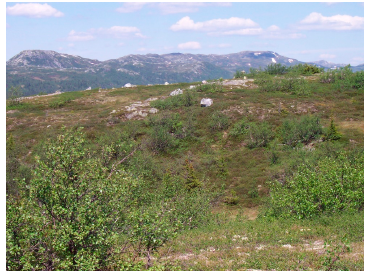
Figure 1. Picture of the landscape and vegetation in the study area.